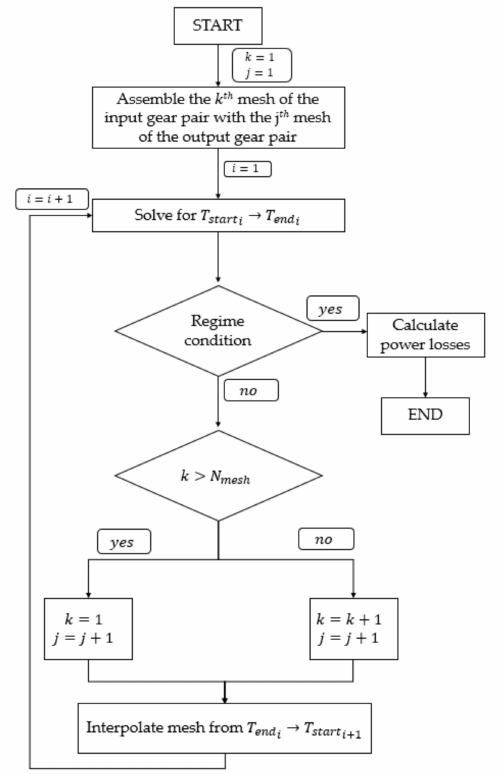
Figure 4. Scheme of the solution procedure.